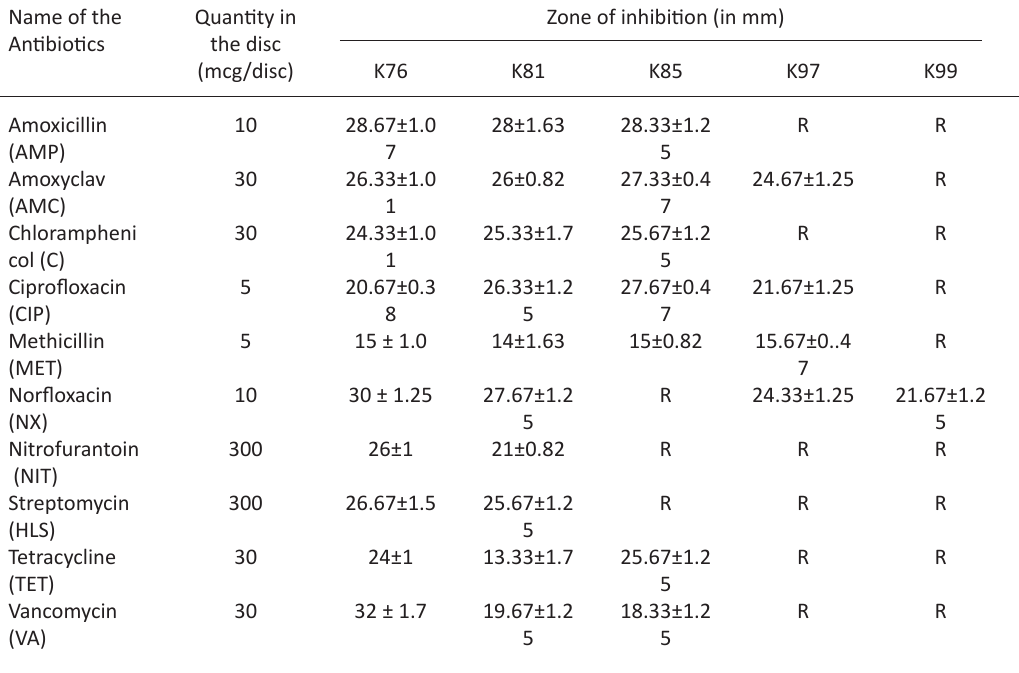
Table 4. Antibiotics susceptibility of Lactobacillus mucosae (K76), L. fermentum (K81), L. fermentum (K85), L. reuteri (K97) and L. reuteri K99). Error bars indicate ± standard